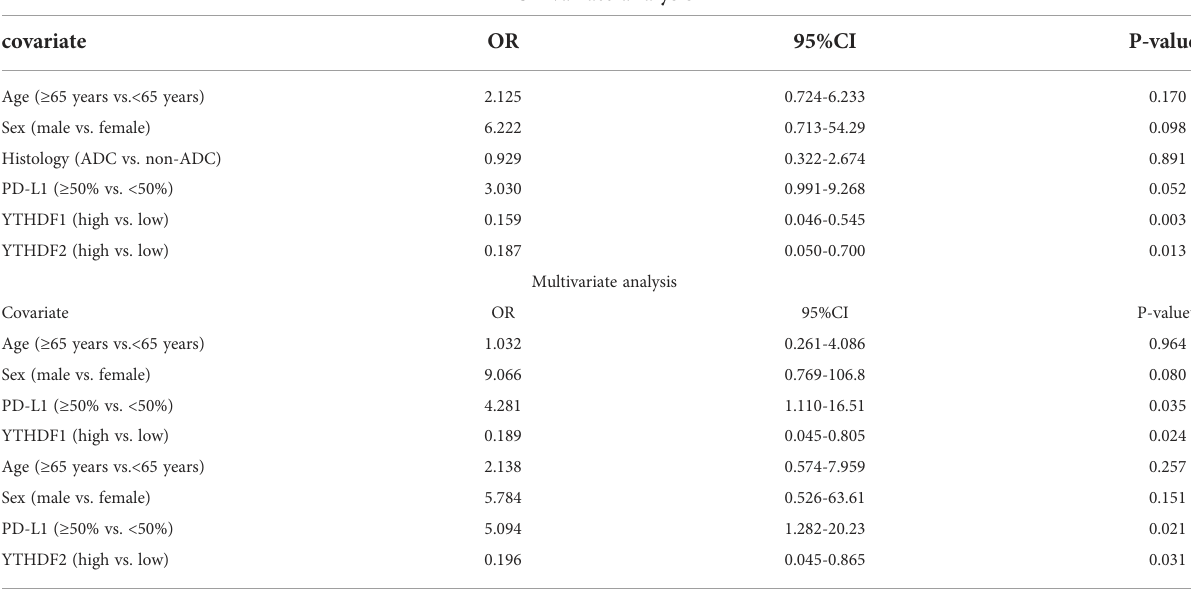
Figure 2D, respectively). We provided the immunhistochemical data of the PD-1 inhibitor treatment group and non-treatment group in the form of Supplementary material Datasheet 1 (treatment group) and Supplementary material Datasheet 2 (non- treatment group). TABLE 3 Univariate and multivariate logistic regression analysis for predicting clinical response to PD-1/PD-L1 blockade. Univariate analysis